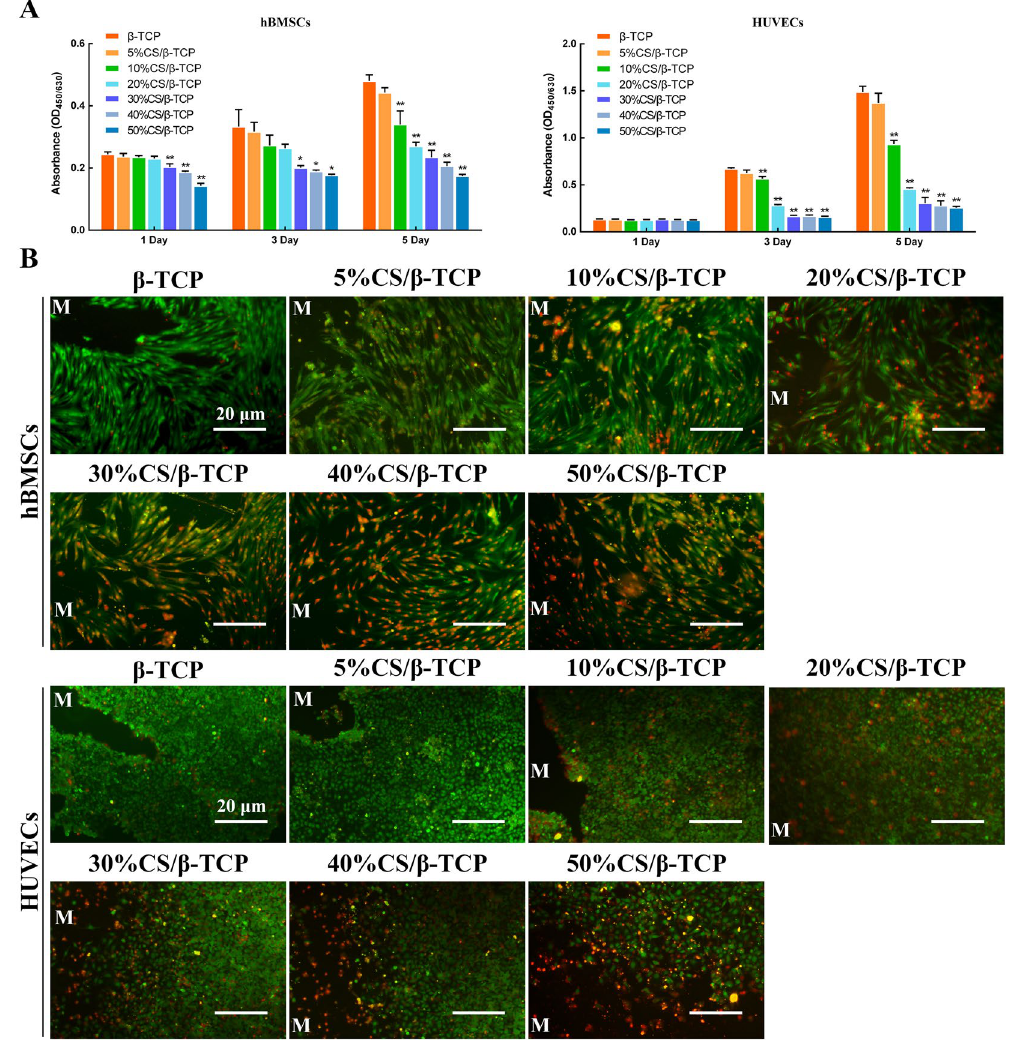
Figure 1. Cell viability on 5%CS/ β -TCP scaffolds. ( A ) Cell viability, as measured by Cell Counting Kit-8, was comparable between β -TCP scaffolds and other composite scaffolds. Cell viability was significantly inhibited on scaffolds with more than 10% CS. ( B ) Cell viability of cells around scaffolds was also visualized by Live/ Dead Kit, which stains viable cells green and dead cells red. * p < 0.05; ** p < 0.01. Scale bar represents 20 μ m. M marked